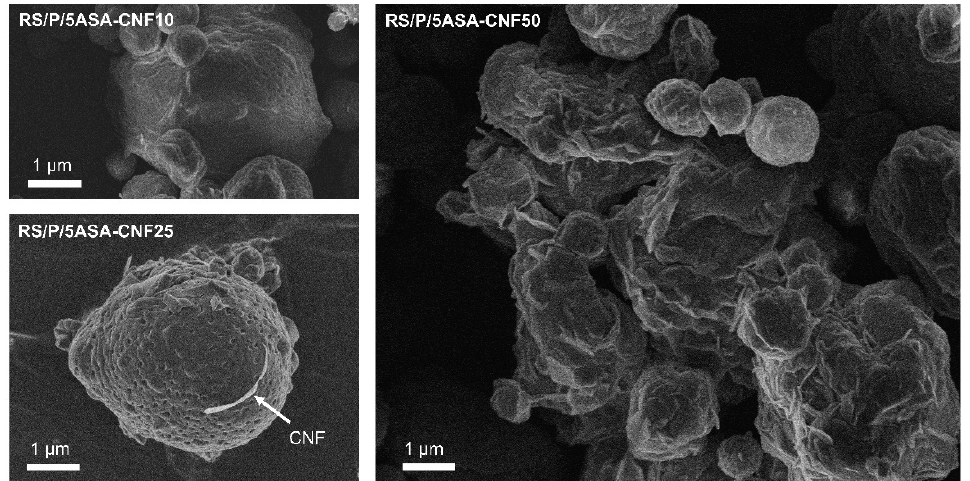
Figure 6. FEG/SEM images of 5-ASA-loaded RS/P samples containing different amounts of CNF (10%, 15% and 50%). The images were obtained with 10,000× magnification.